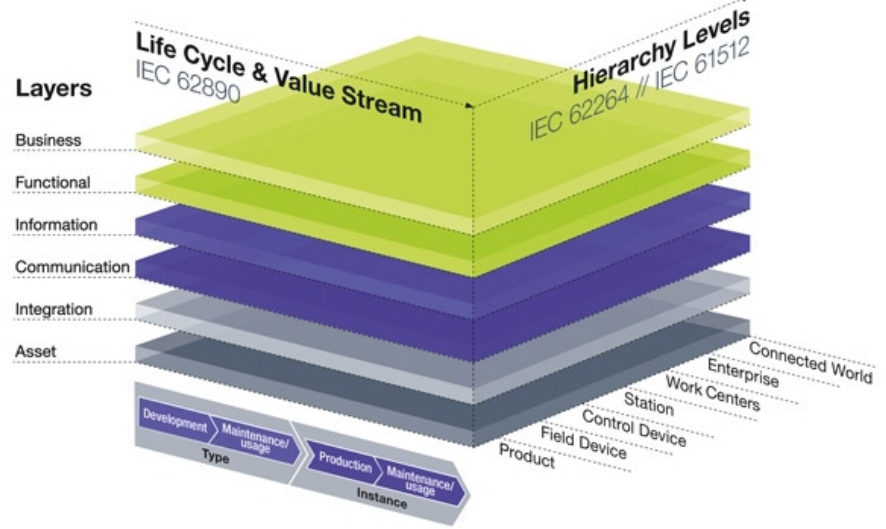
Figure 13. RAMI 4.0 (Reference Architecture Model I4.0) by ZVEI [75].